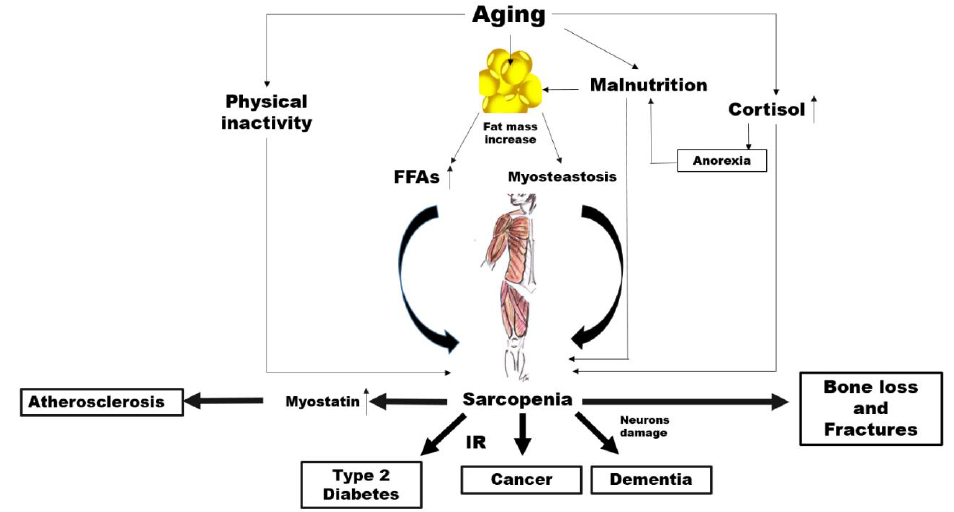
Figure 1. Potential mechanisms linking aging, sarcopenia and noncommunicable diseases (NCDs). FFAs: free fatty acids, IR: insulin